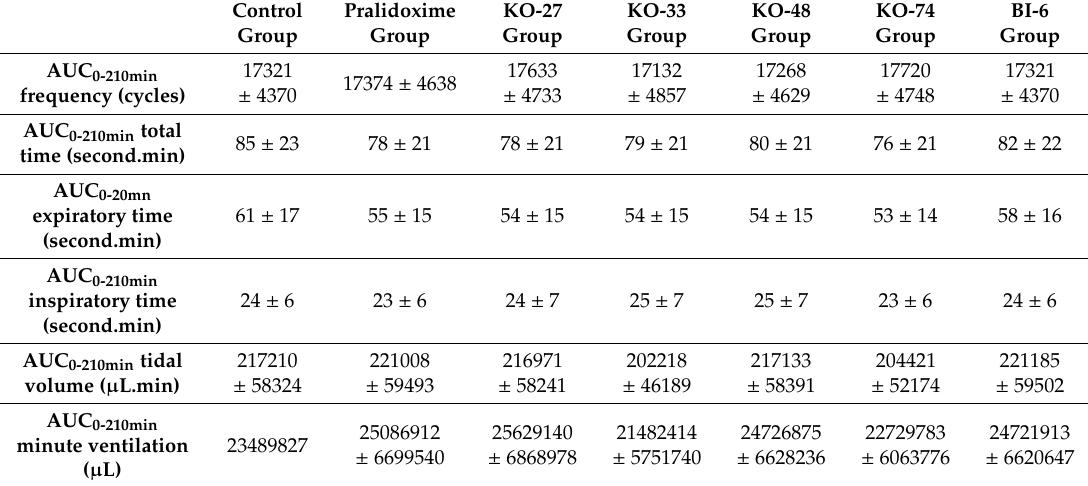
Table 2. Values of AUC from 0 to 210 min for di ff erent respiratory parameters. Each group consisted of five rats. Data are represented by mean ± S.E.M. at each time after injection. Control Pralidoxime KO-27 KO-33 Group Group Group